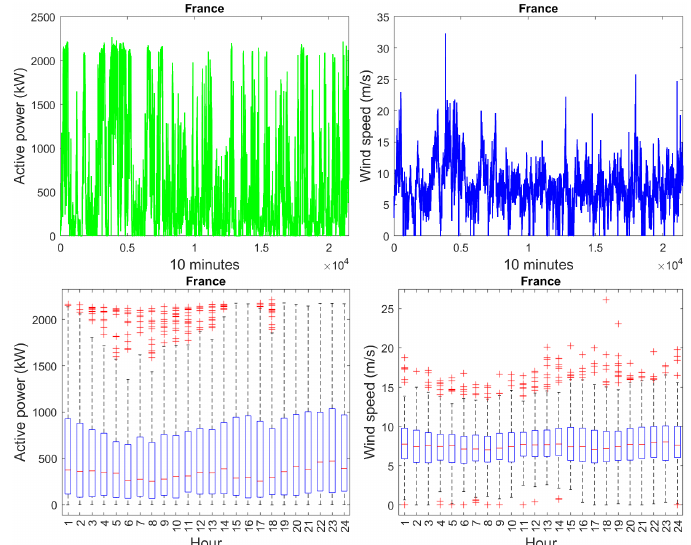
Figure 3. Wind power ( top left ) and wind speed ( top right ) data from France wind turbine; box plot of hourly data for wind power ( bottom left ) and wind speed ( bottom right ).